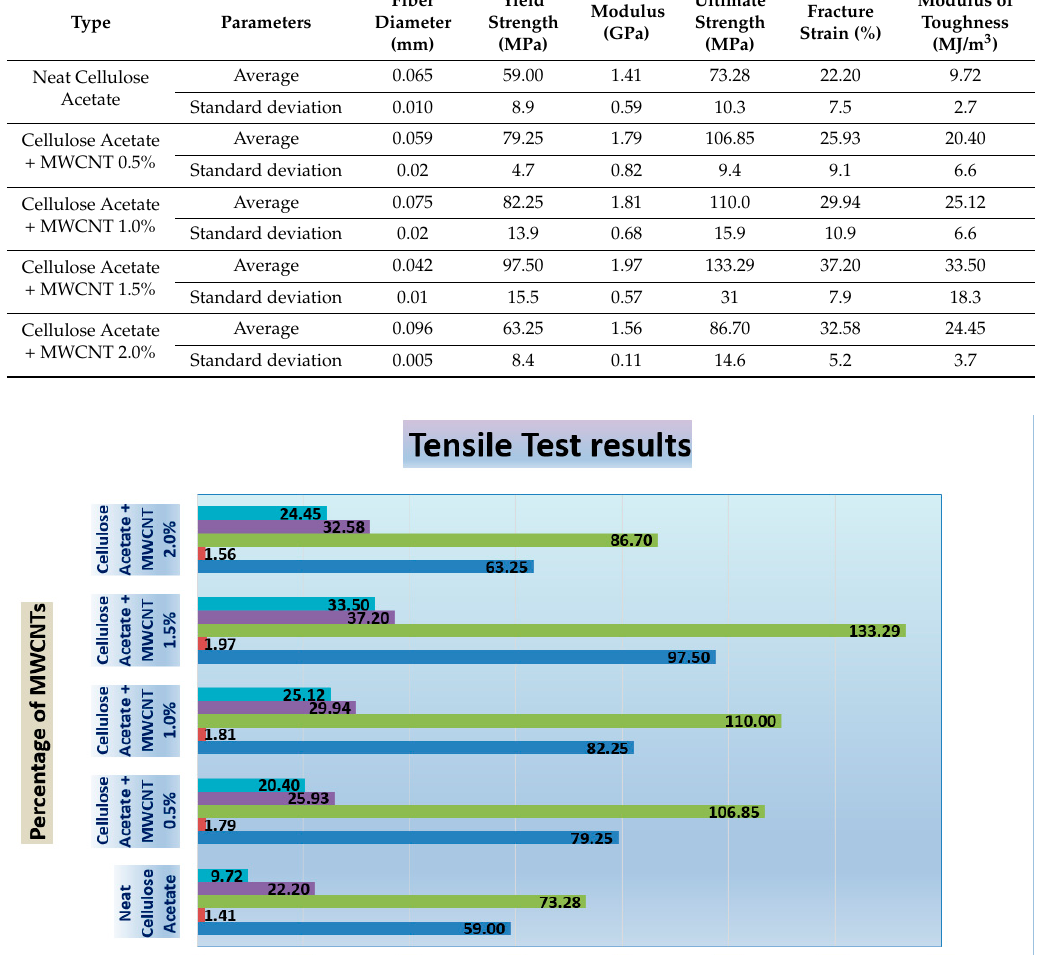
Figure 4. Representative stress-strain curves ( a ) neat CA ( b ) 0.5% CA-MWCNT ( c ) 1.0% CA-MWCNT ( d ) 1.5% CA-MWCNT ( e ) 2.0% CA-MWCNT.